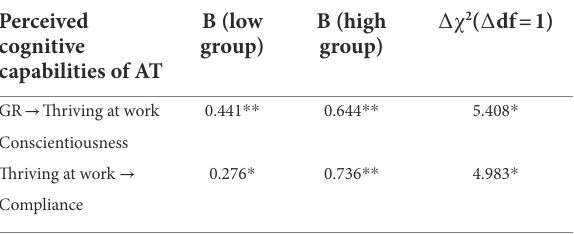
TABLE 4 The moderating effects